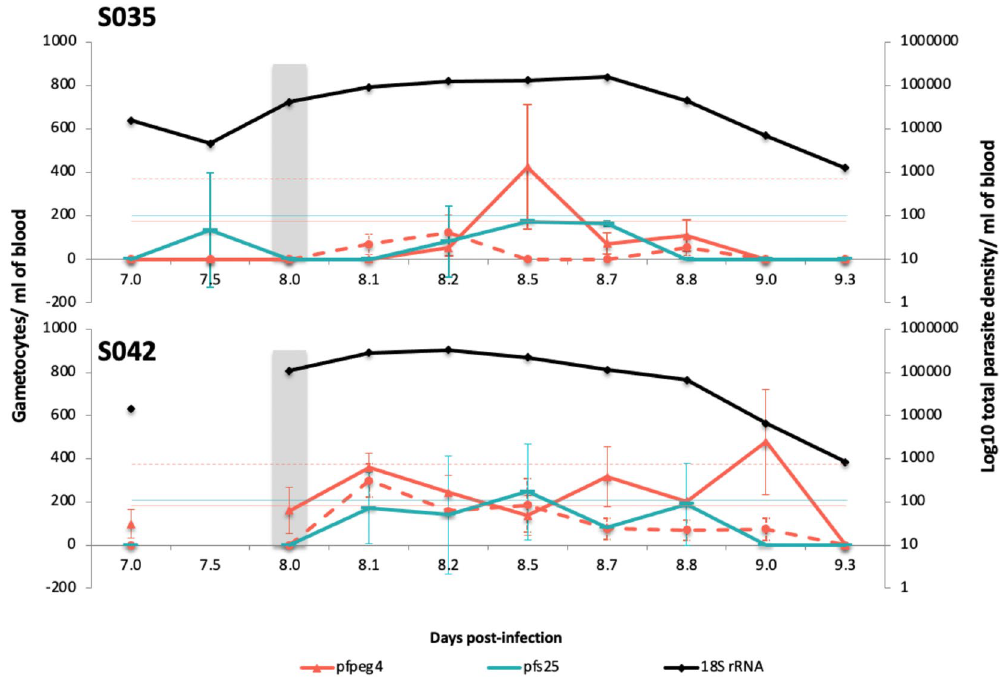
Figure 3. Detection of early gametocytes in vivo in human experimental infections. Left Y axis represents number of gametocytes/mL of blood, quantified by pfpeg4 , pfg27 or pfs25 qRT-PCR. On the right Y axis is plotted total parasite density as quantified by 18S rRNA qPCR. Horizontal lines represent limit of quantification of early and late gametocytes and reads to the left Y axis. Data shown is from 2 volunteers (S035 and S042) during follow up time-points between D07 and D09 post-infection. The X axis represents day post-infection and digits after the decimal points are fractions of that day. Volunteers were treated with piperaquine at D08 (grey shaded column). Data is provided in supplementary file (Table